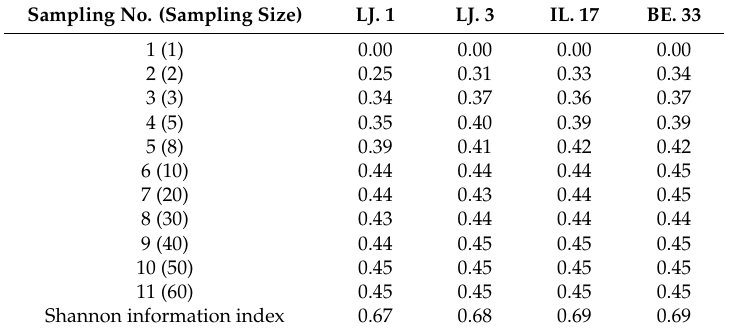
Table 3. The Fixation index values (FST) and the Shannon information index of the four accessions. Sampling No. (Sampling